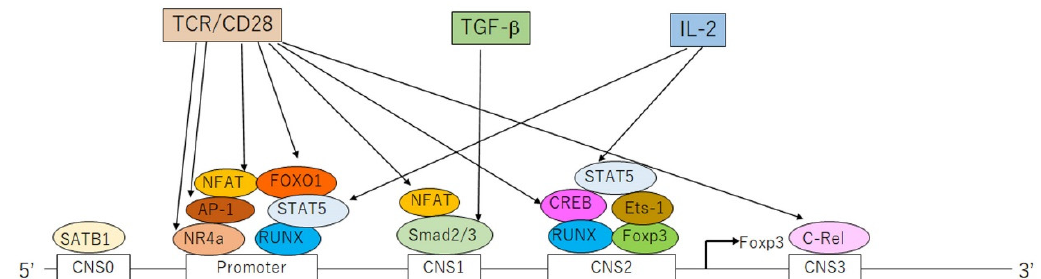
Figure 3. Forkhead box protein 3 ( Foxp3 ) gene expression in regulatory T cells. Foxp3 gene contains five enhancer elements: four conserved non-coding sequences (CNS0–3) and a promoter. Foxp3 expression is initiated by the binding of self-antigens to the T-cell receptor (TCR) in combination with a co-stimulatory signal, CD28, together with transforming growth factor (TGF)- β and interleukin (IL)-2. These activation signals provoke the recruitment and binding of transcription factors to individual response elements. The TCR/CD28 signal induces the binding of activator protein-1 (AP-1), nuclear factor of activated T cells (NFAT), nuclear receptor 4a (NR4a), forkhead box-containing protein O subfamily 1 (FOXO1), cyclic AMP response element-binding protein (CREB), and c-Rel. TGF- β induces the binding of Smad2/3, and IL-2 induces the binding of signal transducer and activator of transcription 5 (STAT5). SATB1, special AT-rich sequence-binding protein 1; RUNX, runt-related transcription factor.